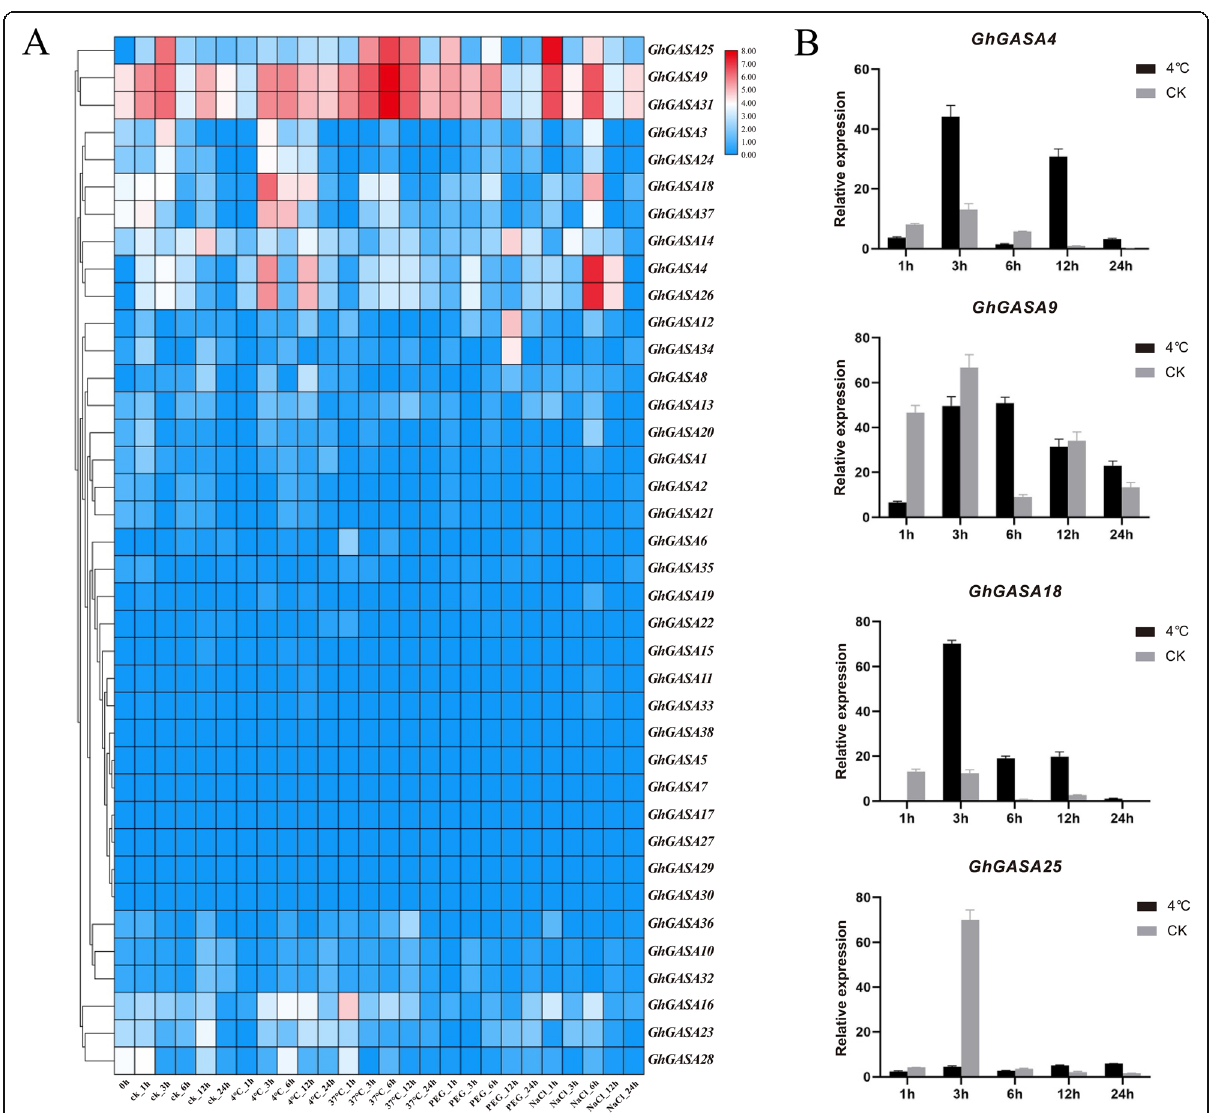
Fig. 5 a Expression profiles of GhGASAs in cotton leaves under abiotic stress. b Expression analysis of GhGASA4 , GhGASA9 , GhGASA18 , and GhGASA25 in cotton leaves under cold treatment based on